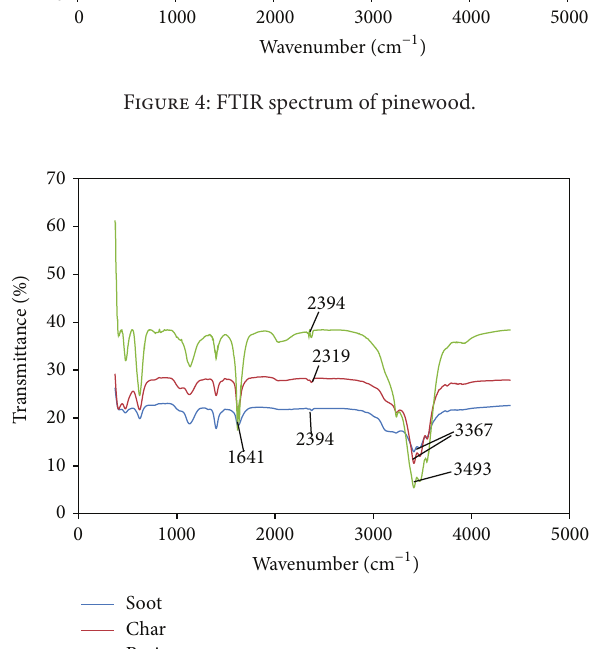
Figure 5: FTIR spectra of pure samples of gasification by-products.